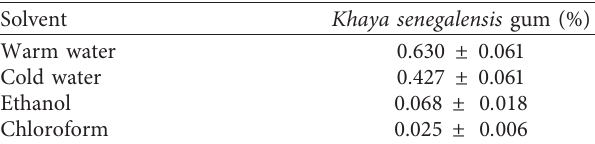
Table 2: Solubility of purified gum in different solvents ( n �